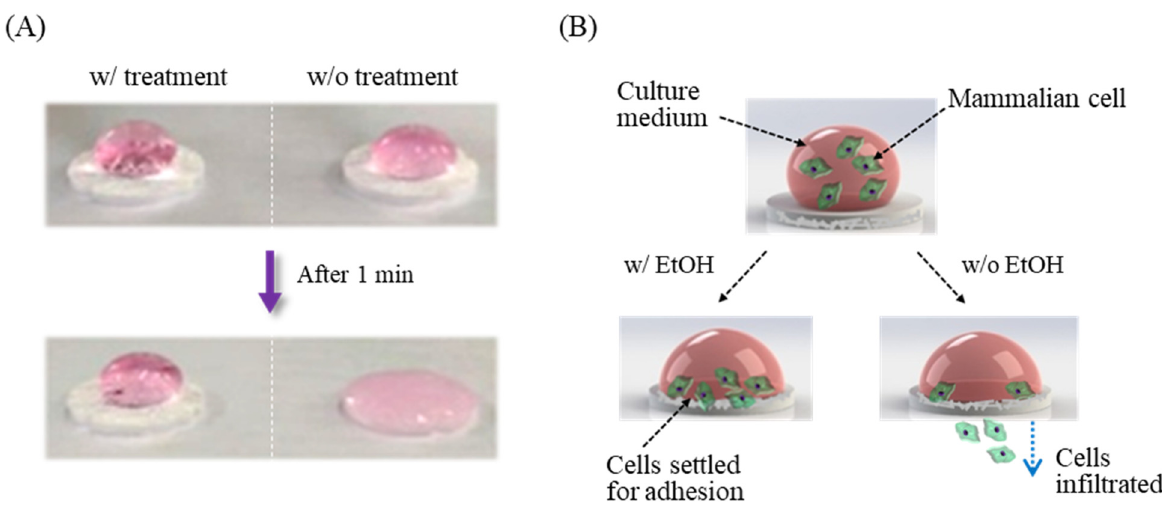
Figure 3. Physiochemical modification of the polyester membrane surface. ( A ) The hydrophobic surface of polyester membrane underwent ethanol treatments, maintaining the droplet form of the cell culture medium. The hydrophilic membrane without surface treatment immediately infiltrated the culture medium, reaching the porous membrane. ( B ) The number of immobilized cells was adjusted by slow infiltration of cell culture media onto the hydrophobic membrane.